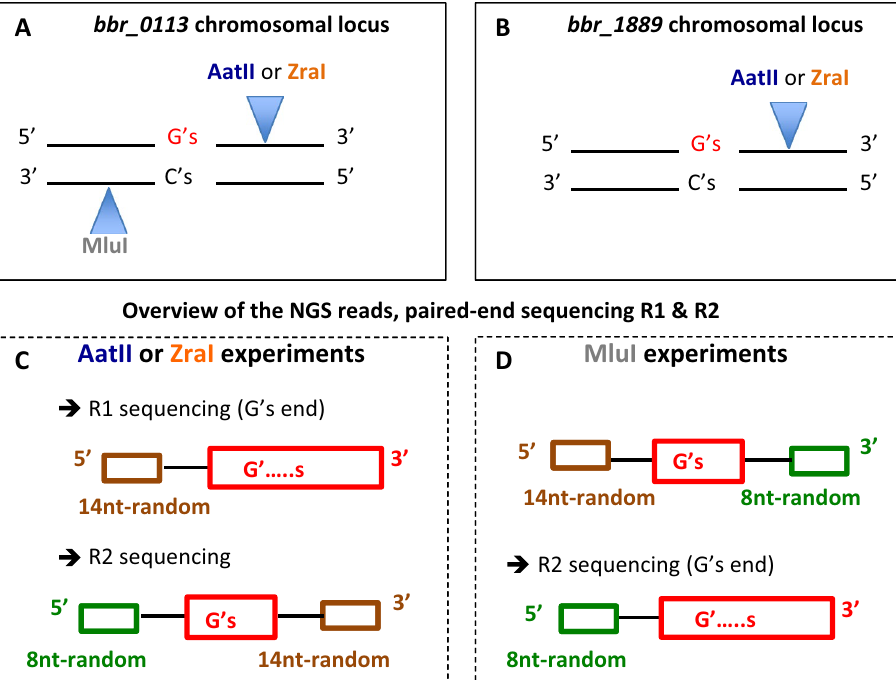
Figure 4. G’s end phenomenon. The position of available restriction sites present in the double stranded chromosomal locus of bbr_0113 ( A ) and bbr_1889 ( B ) used to generate a newly 3’end, downstream the sequence of interest, of one of the two chromosomal DNA strands are indicated. Because this 3’ end incorporates a 14nt random tag and the complementary sequence of the NGS primer R1 during the first step of MDS, the corresponding NGS reads generated using R1 will sequence first the 14nt family tag, followed by the tract, and then the 8nt tag. When MDS targets a chromosomal strand containing a G-tract (using either AatII or ZraI), the NGS read generated with primer R1 causes a G’s end phenomenon, which does not occur for primer R2 ( C ). Conversely, when MDS focus on a chromosomal DNA strand containing a C-tract (MluI), the G’s end phenomenon occurs with R2 but not with R1 ( D